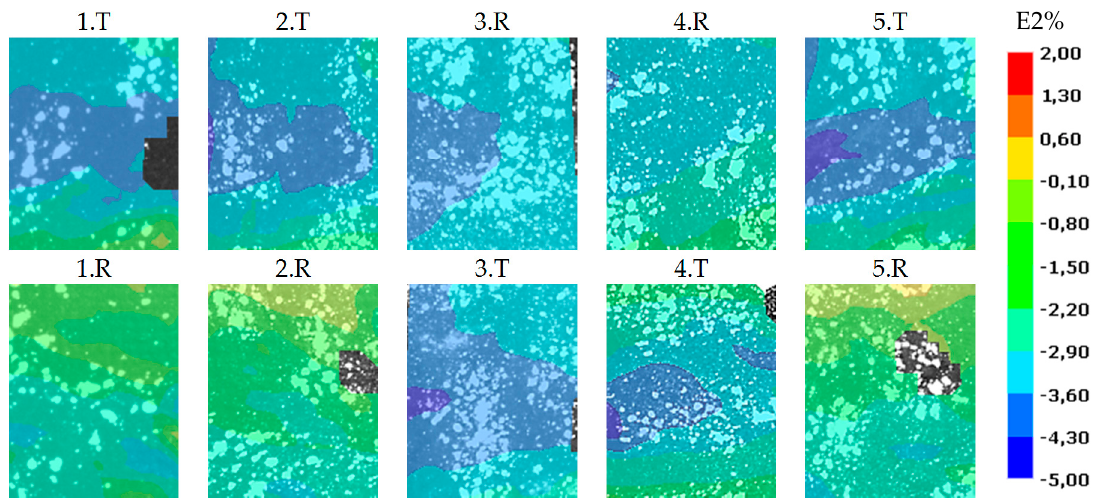
Figure 7. Comparison of transverse strains of specimens 1 – 5. during the compression test at − 1.5% average strain.